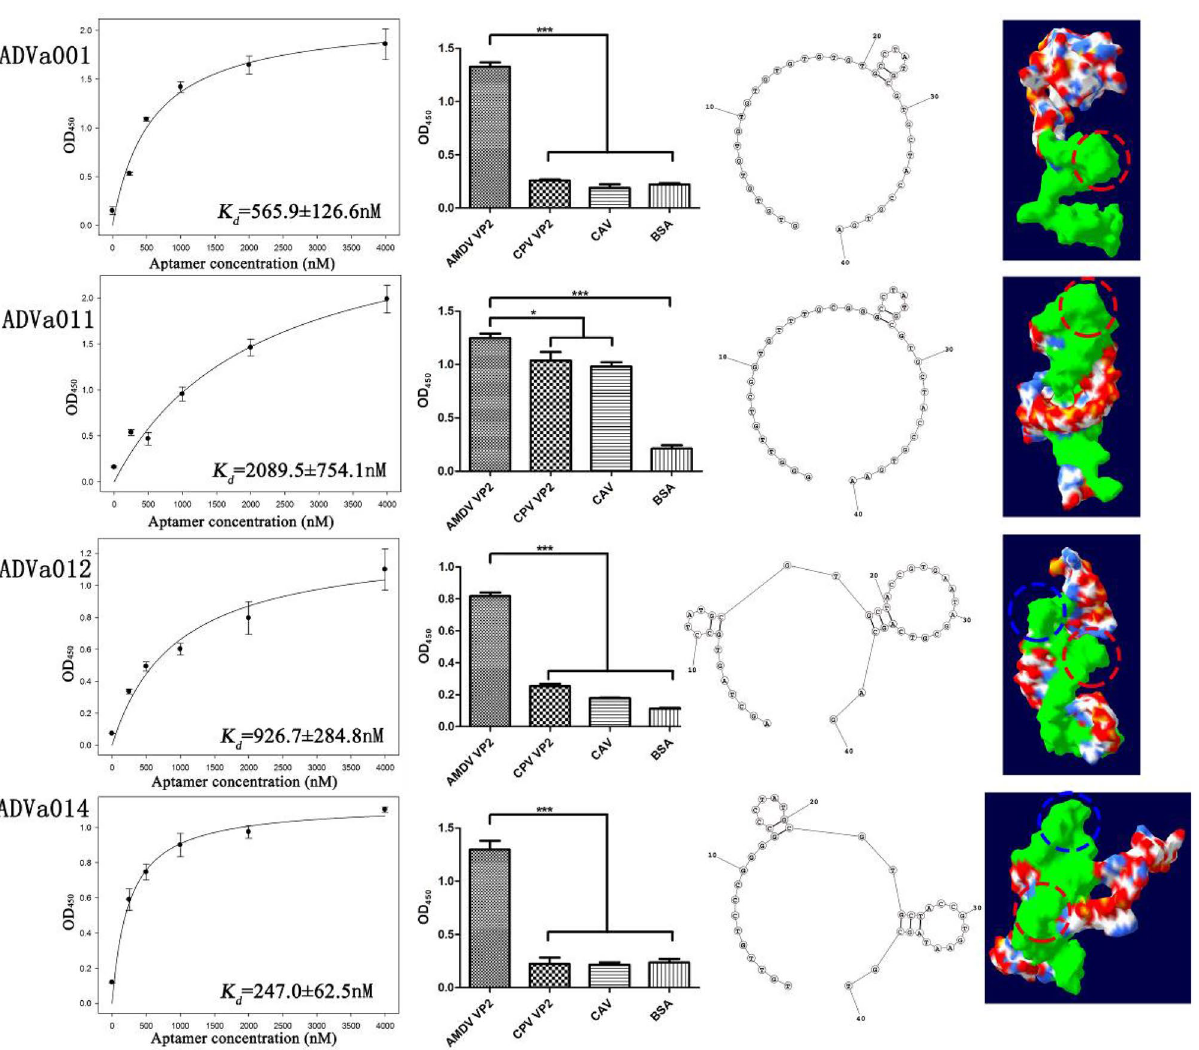
Figure 3. Characterization of aptamers. Calculated K d values, measured by ELONA (565.9 ± 126.6 nM for ADVa001, 2089.5 ± 754.1 nM for ADVa011, 926.7 ± 284.8 nM for ADVa012 and 247.0 ± 62.5 nM for ADVa014), are shown in the first column. The resulting absorbance values (OD450) were normalized and plotted against the aptamer concentration using Sigma Plot version 12.0 software. Specificity of the four aptamers for AMDV VP2 protein and three counter targets, canine parvovirus VP2 protein, canine adenovirus (CAV) and Bull Serum Albumin (BSA) is shown in the second column. P values < 0.05 were considered to be statistically significant. Structural analyses of the four aptamers, performed using RNA structure 6.0 and 3dRNA-V2.0 online tools to predict the 2-D and 3-D structures, are shown in the last two columns. *P < 0.05; **P < 0.01. The secondary structures of the candidate aptamers were predicted using the RNAstructure online program (version 6.0.1) (http://rna.urmc.roche ster.edu/). The 3D structures were predicted using the mfold (http://unafo ld.rna. alban y.edu/) and 3dRNA-V2.0 (http://bioph y.hust.edu.cn/home.html) website